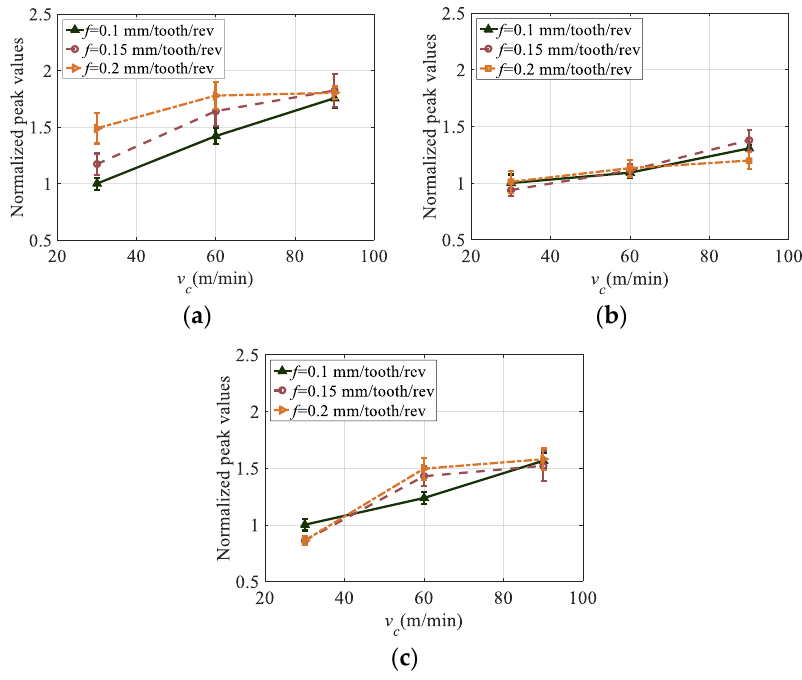
Figure 6. The influence of cutting speed on milling forces: ( a ) Case 1 (milling in XY plane), ( b ) Case 2 (milling in XZ plane), ( c ) Case 3 (milling in YZ plane) for the workpiece built with SSR of 90°.